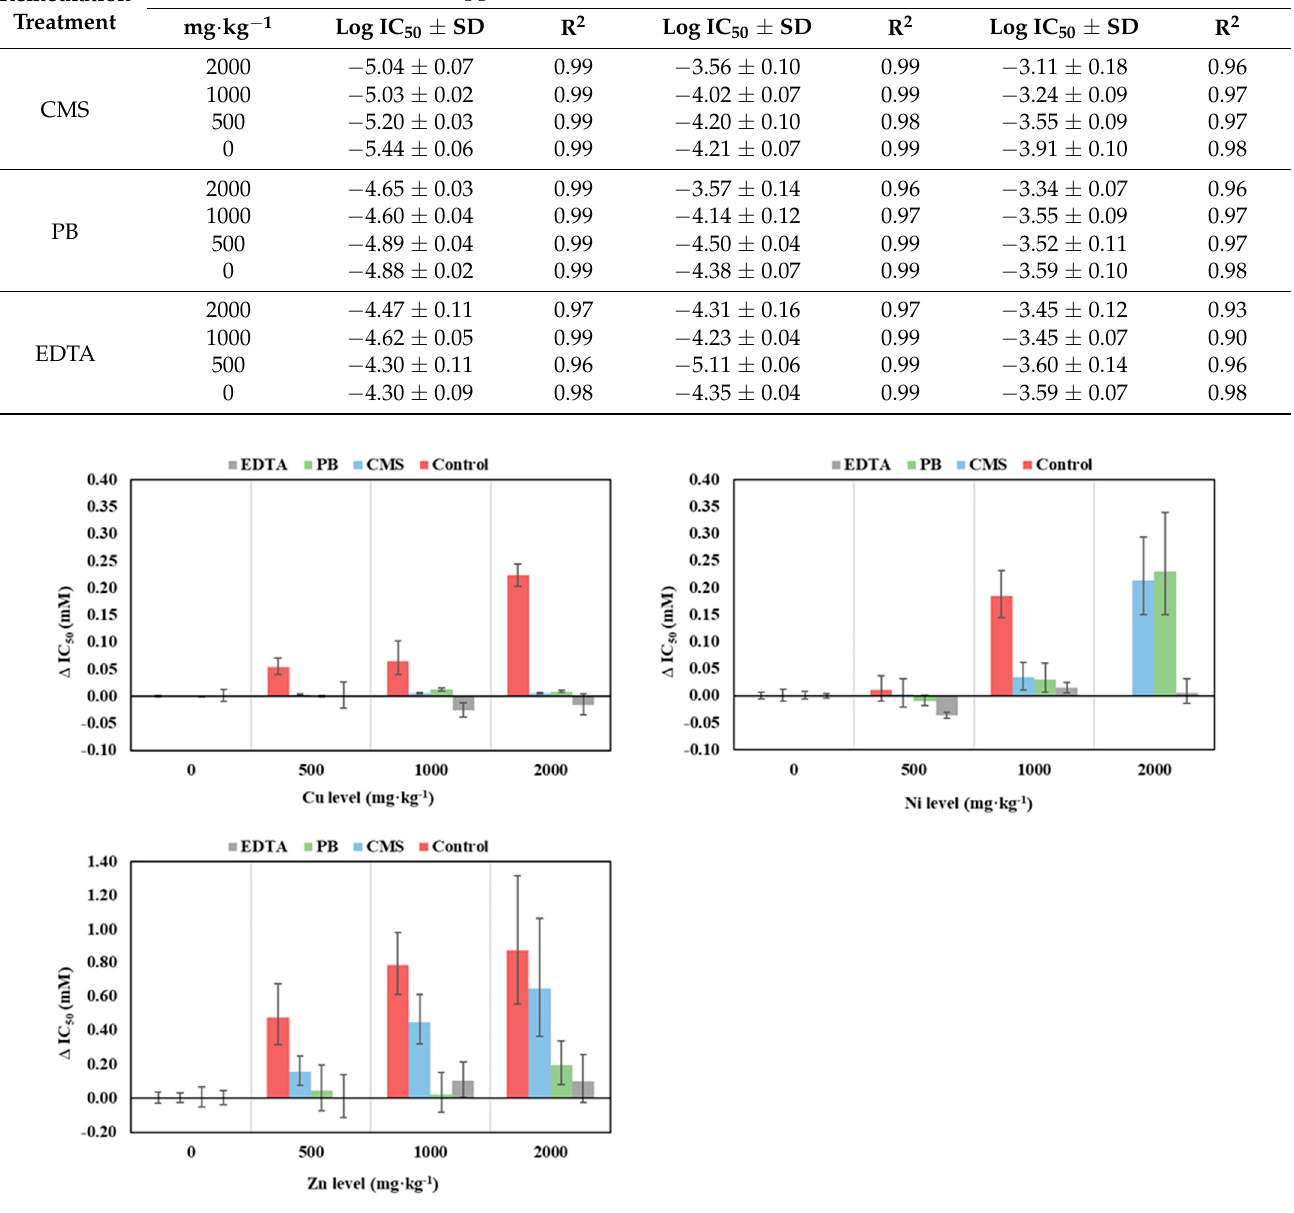
Figure 4. Effect of four remediation techniques (crushed mussel shell –CMS-, pine bark –PB-, EDTA, and control –no treatment-) on increased bacterial community tolerance ( ∆ IC 50 ) to Cu, Ni, and Zn in polluted soil samples with four levels of each heavy metal: 0, 500, 1000, and 2000 mg·kg − 1 . Blue bars represent CMS amendment, green bars represent PB amendment, grey bars represent EDTA treatment, and red bars represent the control. Error bars represent standard error ( n = 3). Table 1. Bacterial community tolerance to Cu, Ni, and Zn in a polluted soil with four metal levels (0, 500, 1000, and 2000 mg·kg − 1 ). Each metal level was remediated with four remediation treatments: crushed mussel shell amendment (CMS), pine bark amendment (PB), EDTA, and control (no treat- ment).